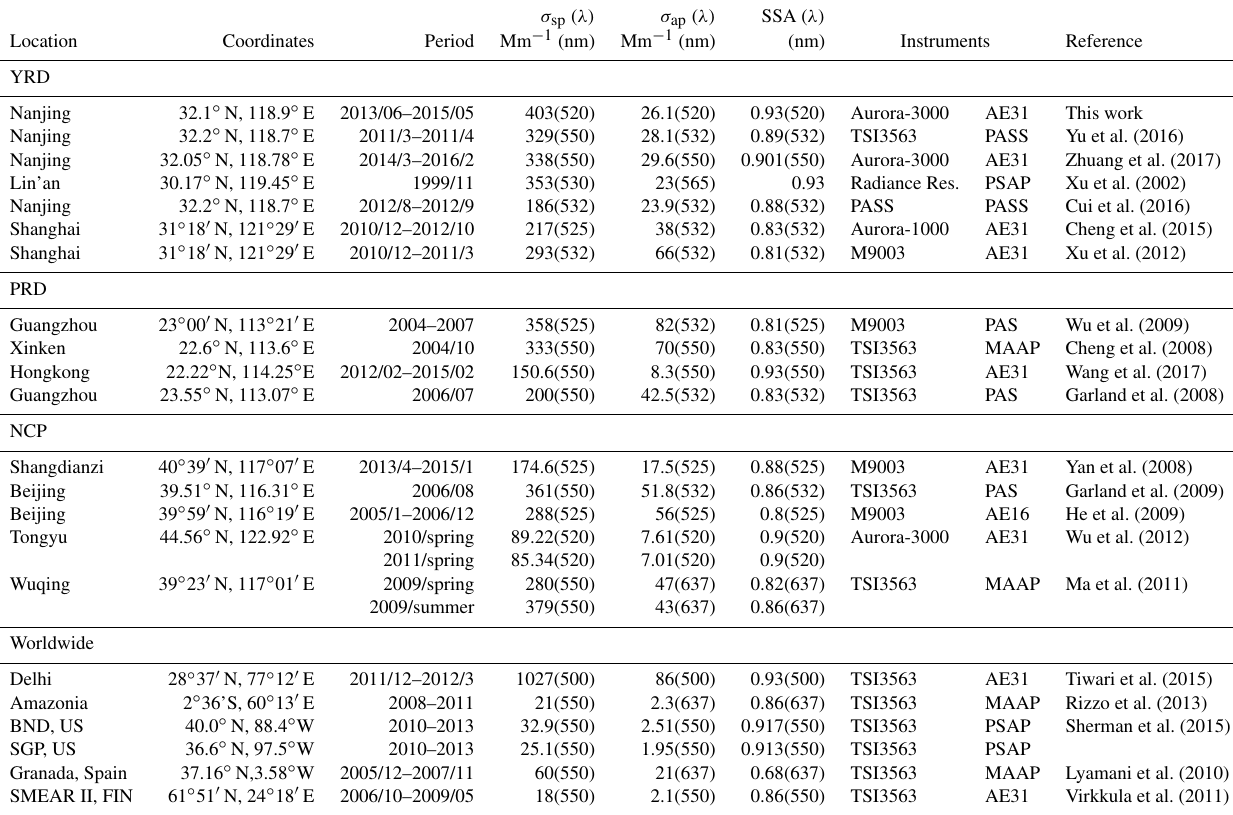
Table 2. Published scattering coefficients ( σ sp ) , absorption coefficients ( σ ap ), and single-scattering albedos (SSA) at selected Chinese and foreign sites. The numbers in parentheses show the wavelength of the respective parameter in